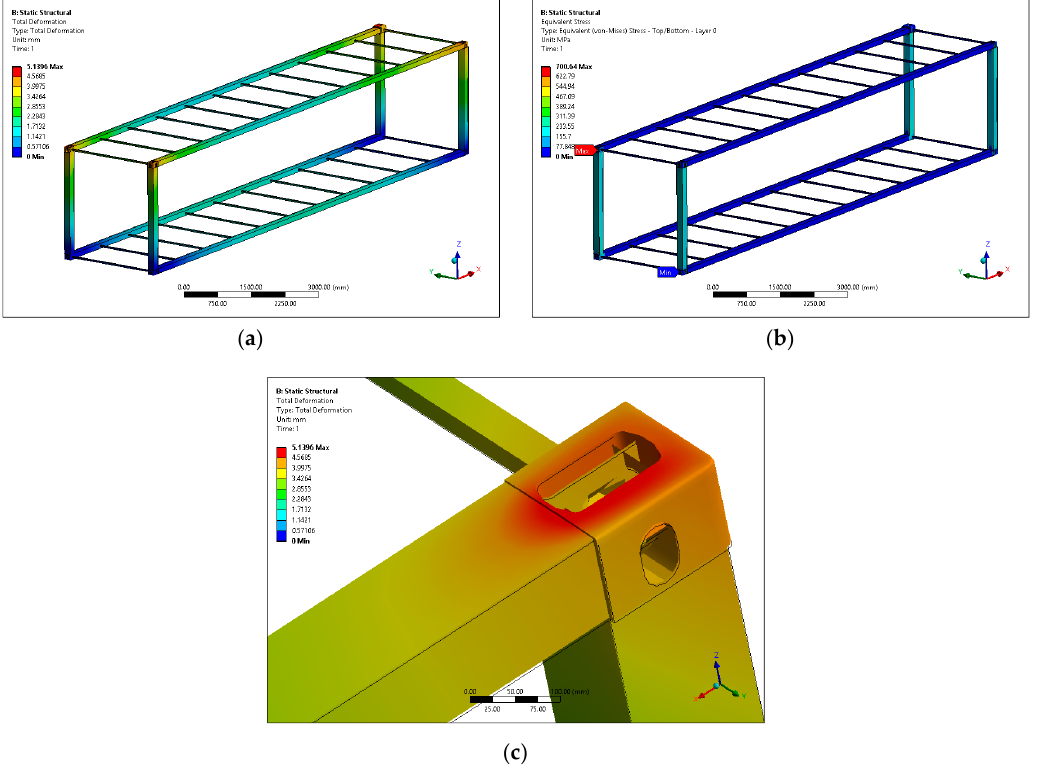
Figure 6. ( a ) Stacking: Total deformation (1000 kN negative z direction), ( b ) stacking: Von Mises stress distribution (1000 kN negative z direction), and ( c ) lifting: Total deformation (1000 kN positive z direction).